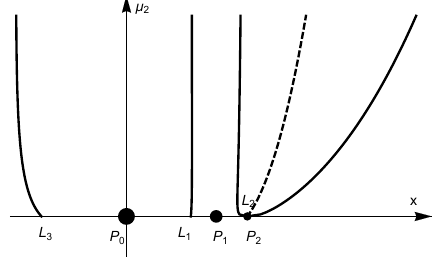
Figure 6. Collinear equilibrium positions for 0 ≤ µ 2 ≤ 1, particle P 2 is located near the point L 2 , a > 1, µ 1 = 0 .